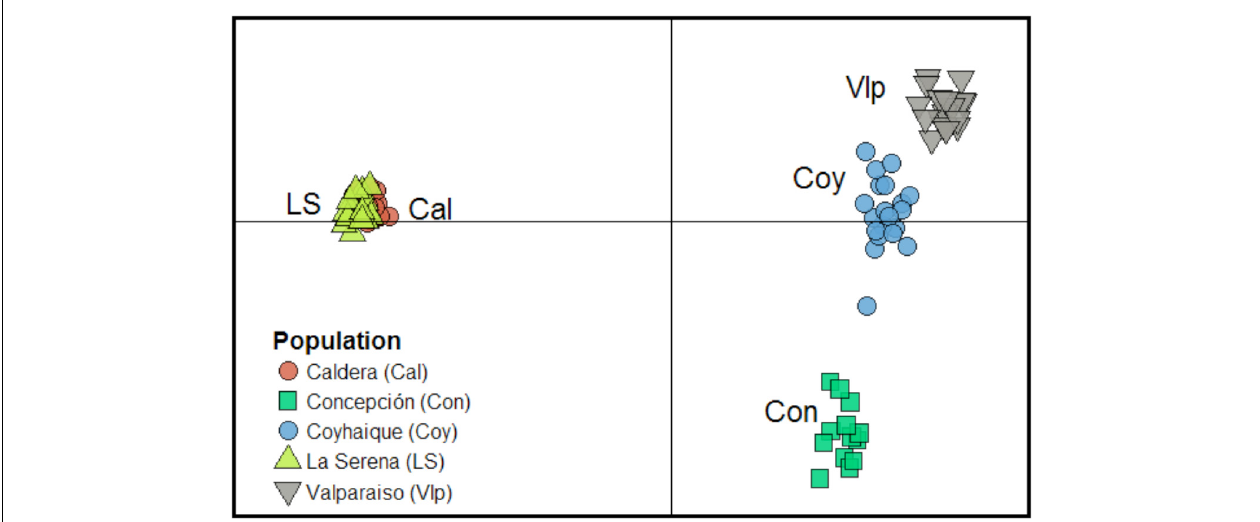
FIGURE 6 | Results of the DAPC analysis over the 196 AFLP loci genotyped for 90 T. officinale individuals. Samples from five localities are included (Caldera, La Serena, Valparaiso, Concepción and Coyhaique) along the latitudinal gradient. The first two discriminant functions show that most genetic variation is explained by four clusters, with a clear divergence between northern and southern